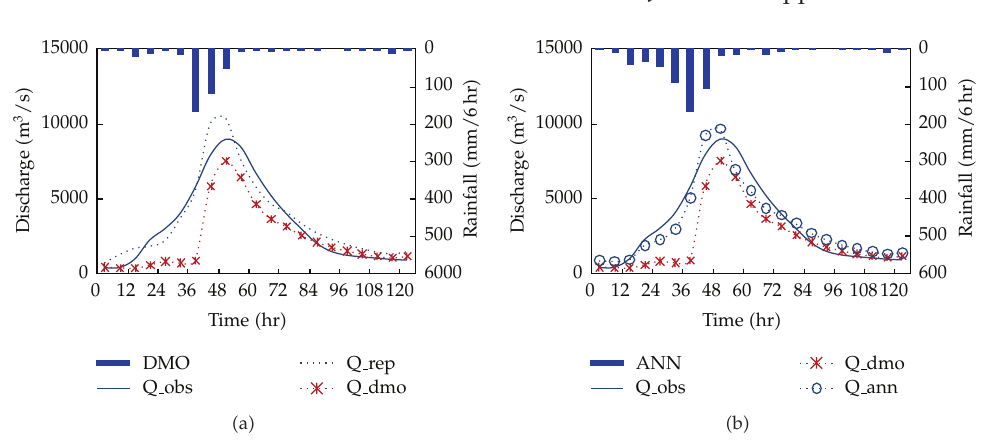
Figure 5: Time series of observed hydrograph (cid:2) Q obs (cid:3) and those based on di ff erent precipitation estimation: (cid:2) a (cid:3) observed by rain gages (cid:2) Q rep (cid:3) and derived from direct model outputs (cid:2) Q dmo (cid:3) , and (cid:2) b